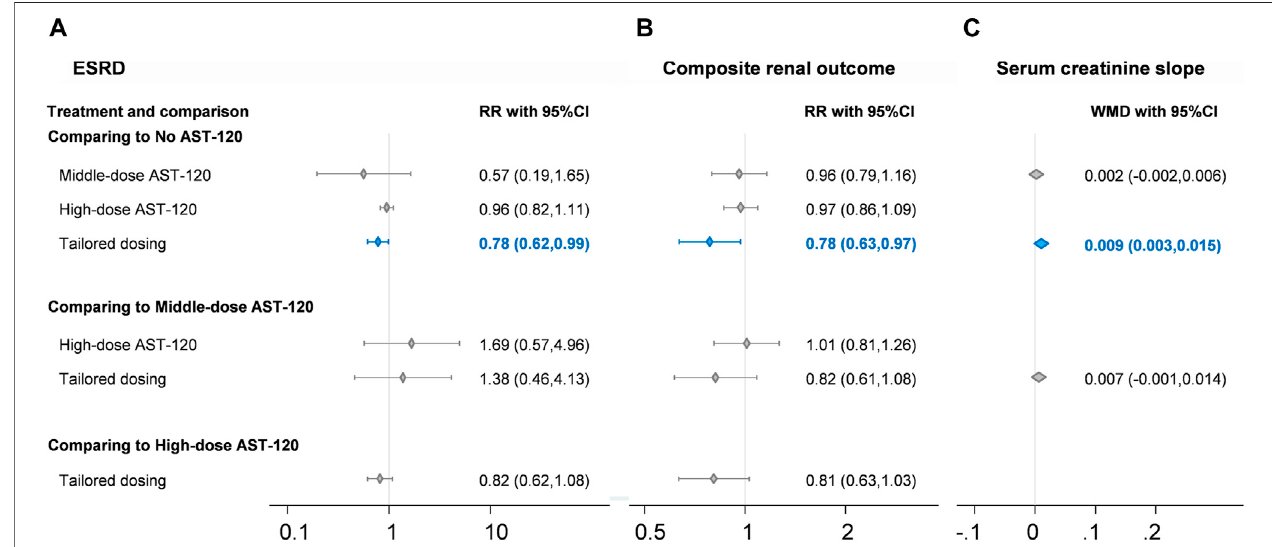
FIGURE 3 | Forest plots of (A) end stage renal disease, (B) composite renal outcome, and (C) serum creatinine slope. CI, con fi dence interval; ESRD, end stage renal disease; RR, risk ratio. Blue diamond and line indicate statistically signi fi cant fi ndings.